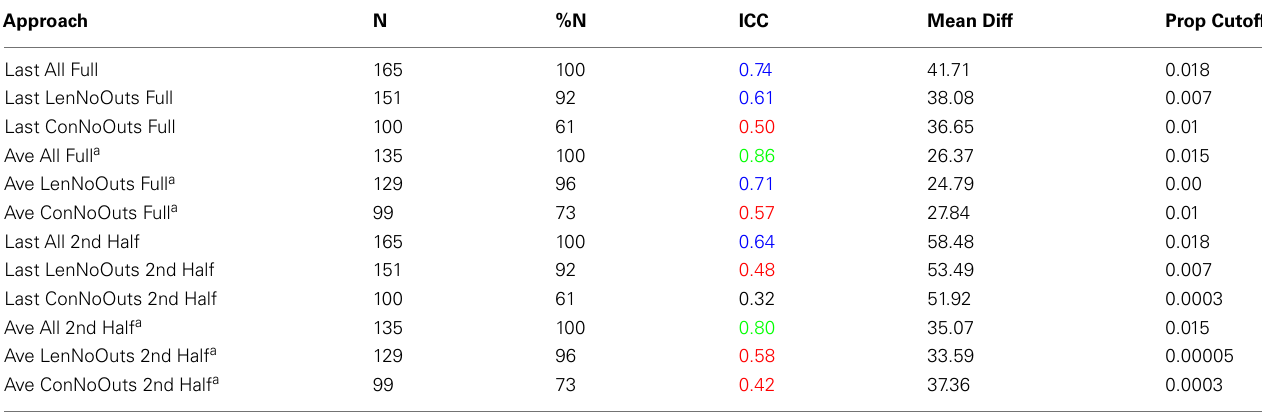
Table 2 | Reliabilities of SSRT calculation